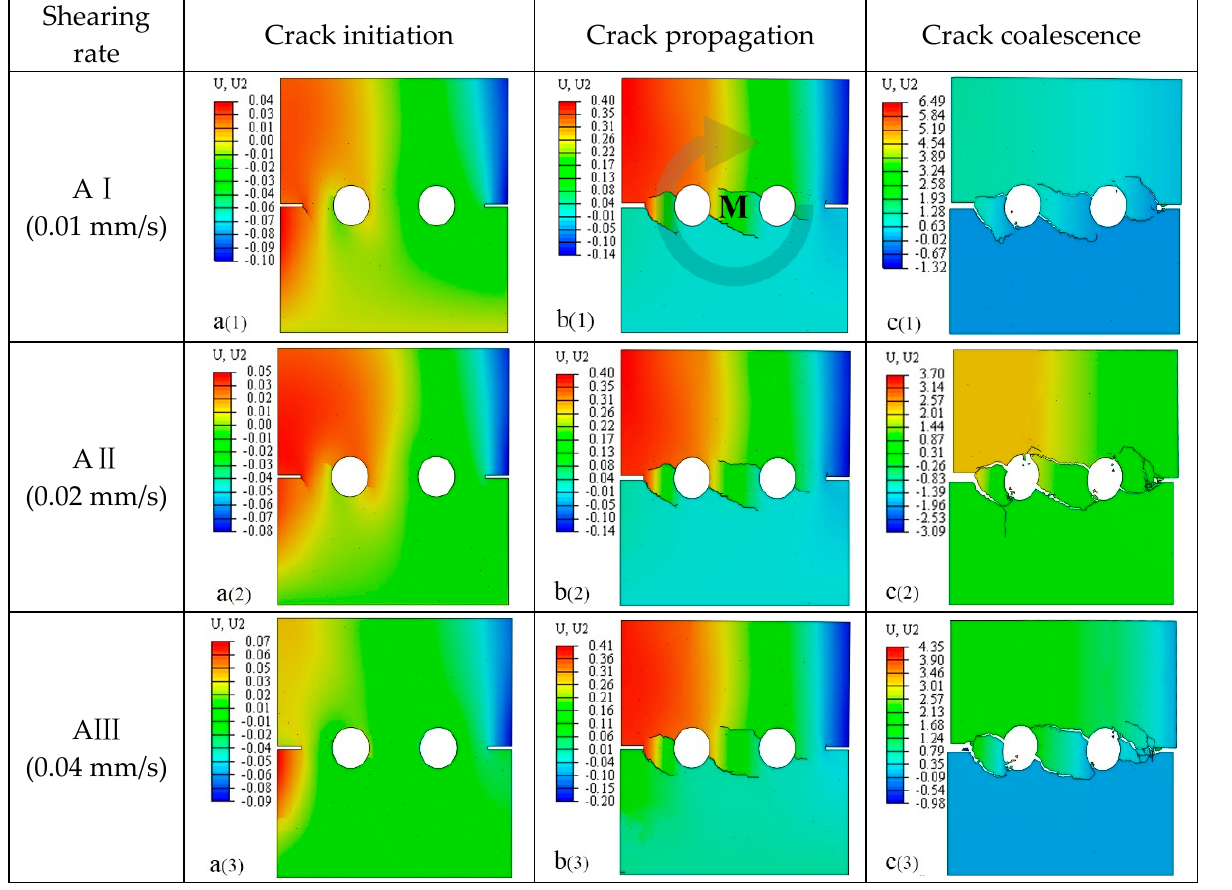
Figure 9. The normal displacement field and the persistency of different shearing rates and normal stress was 1.0 MPa. a(1)–a(3). The stage of crack initiation; b(1)–b(3). The stage of crack propagation; c(1)–c(3). The stage of crack coalescence.